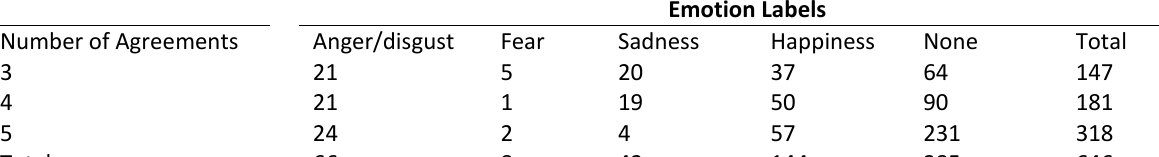
Table 2. Gold standard: Emotion labels and number of agreements.